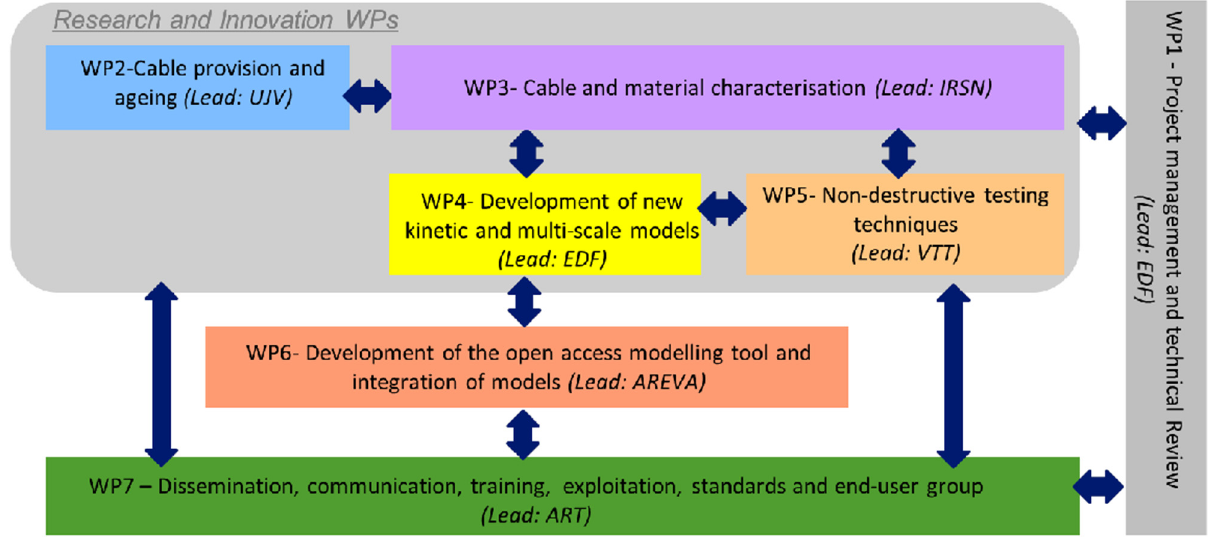
Fig. 3. TEAM CABLES work